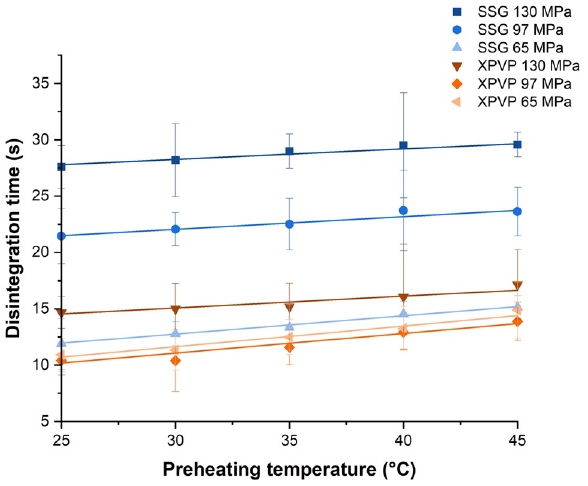
Figure 7. Plots of disintegration time at 37 °C against preheating temperature for tablets made with SSG or XPVP, produced at different compaction pressures. Note: All trend lines drawn are best fit lines.